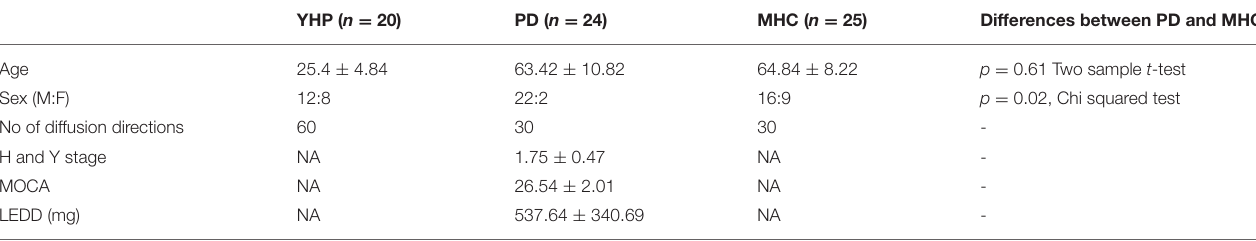
TABLE 1 | Demographics of the young healthy participants (YHPs), patients with Parkinson’s disease (PD), and matched healthy controls (MHCs). YHP ( n =